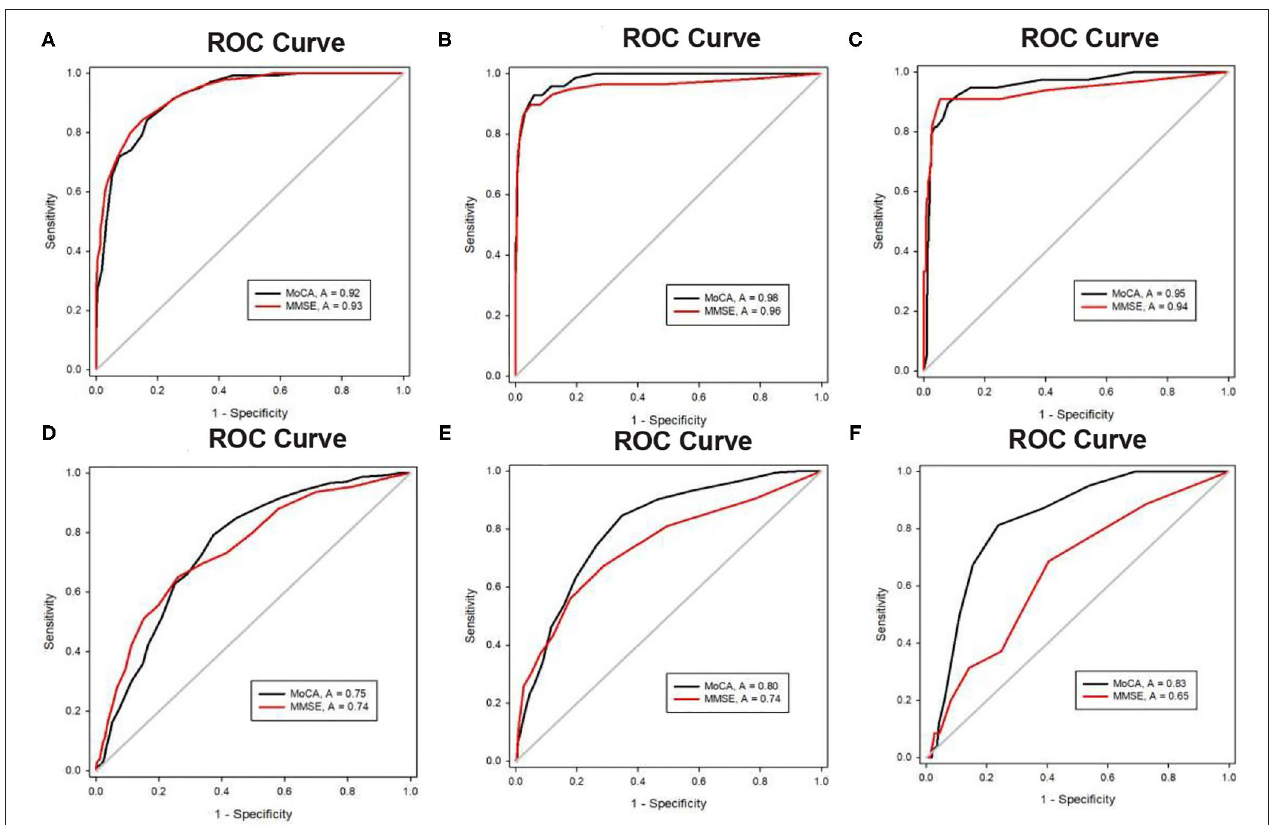
FIGURE 3 | (A) ROC curves for MoCA and MMSE for the detection of dementia in elders with ≤ 6 years of education. (B) ROC curves for MoCA and MMSE for the detection of dementia in the elders with 7–12 years of education. (C) ROC curves for MoCA and MMSE for the detection of dementia in the elders with > 2 years of education. (D) ROC curves for MoCA and MMSE for the detection of MCI in the elders with ≤ 6 years of education. (E) ROC curves for MoCA and MMSE for the detection of MCI in the elders with 7–12 years of education. (F) ROC curves for MoCA and MMSE for the detection of MCI in elders with > 12 years of education.